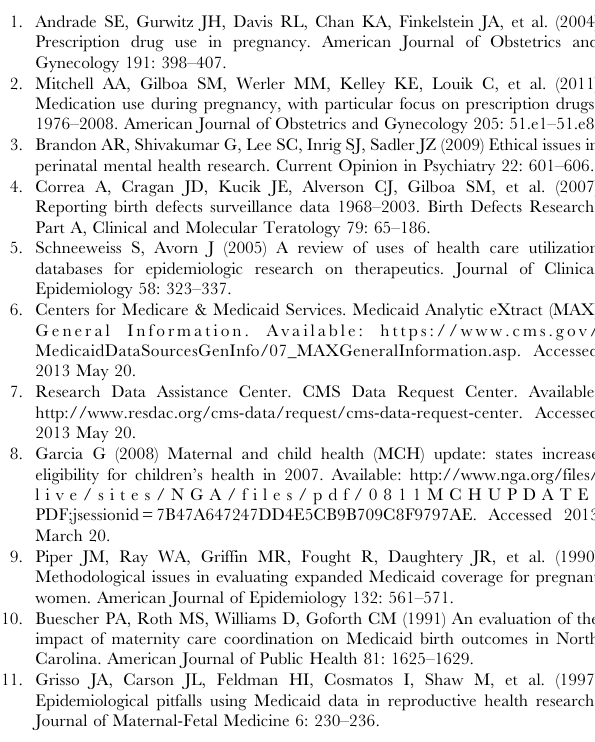
Cohort. Table S1: Delivery-related procedure codes used to identify inpatient and outpatient deliveries from the Medicaid Analytic eXtract, 2000-2007. Table S2: Elements of the Case